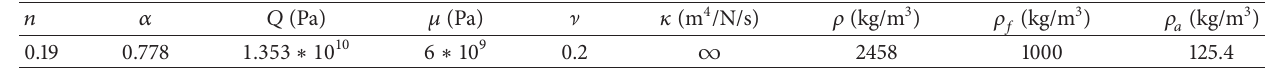
Table 1: Material data for Berea Sandstone (poroelastic medium).